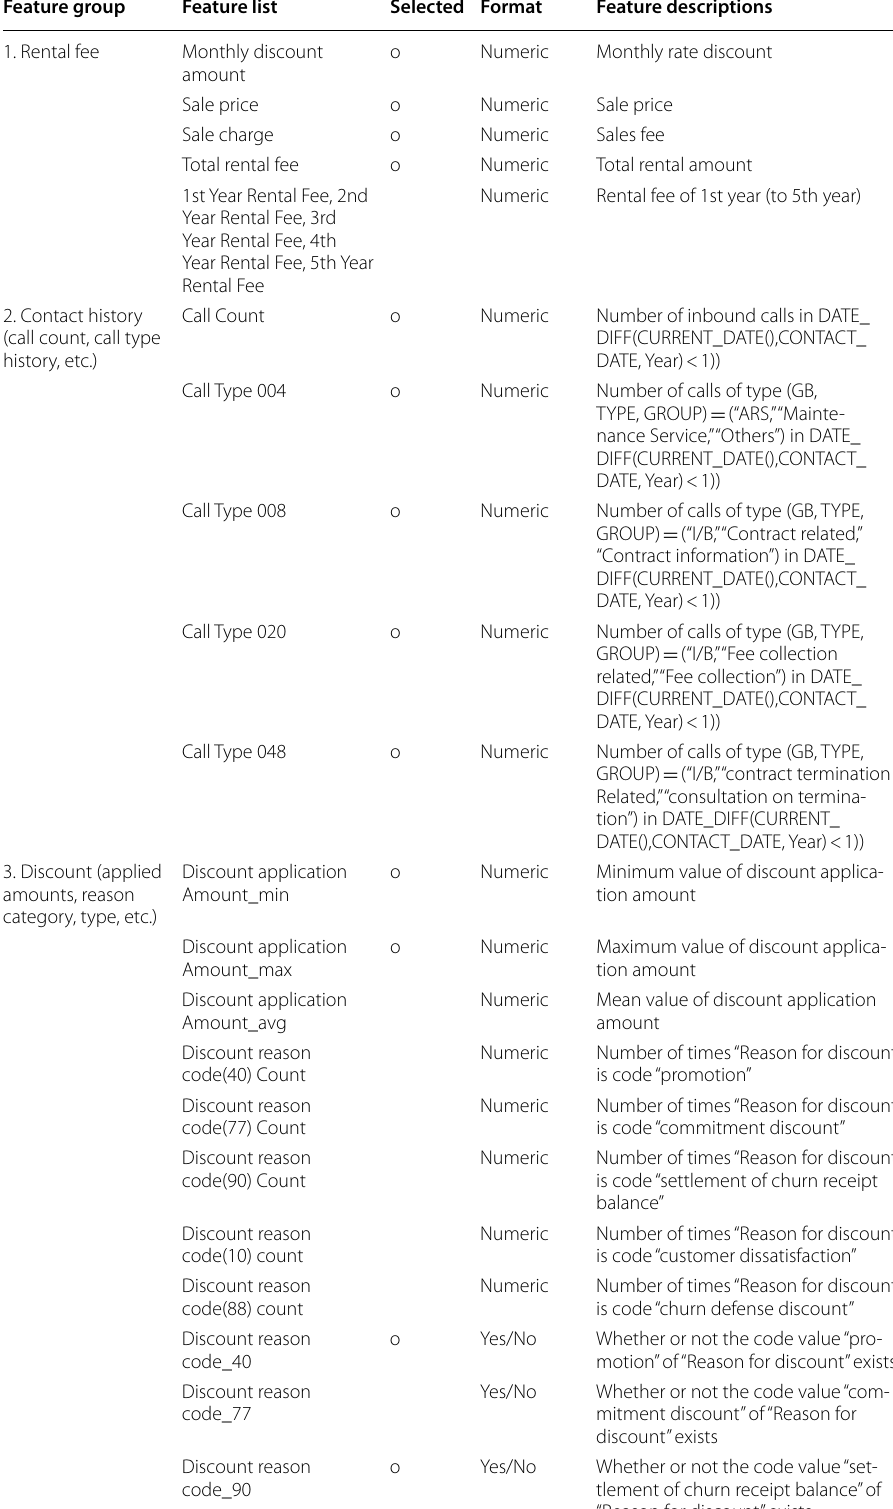
Table 6 List of 80 selected feature set and finally selected 53 features Feature